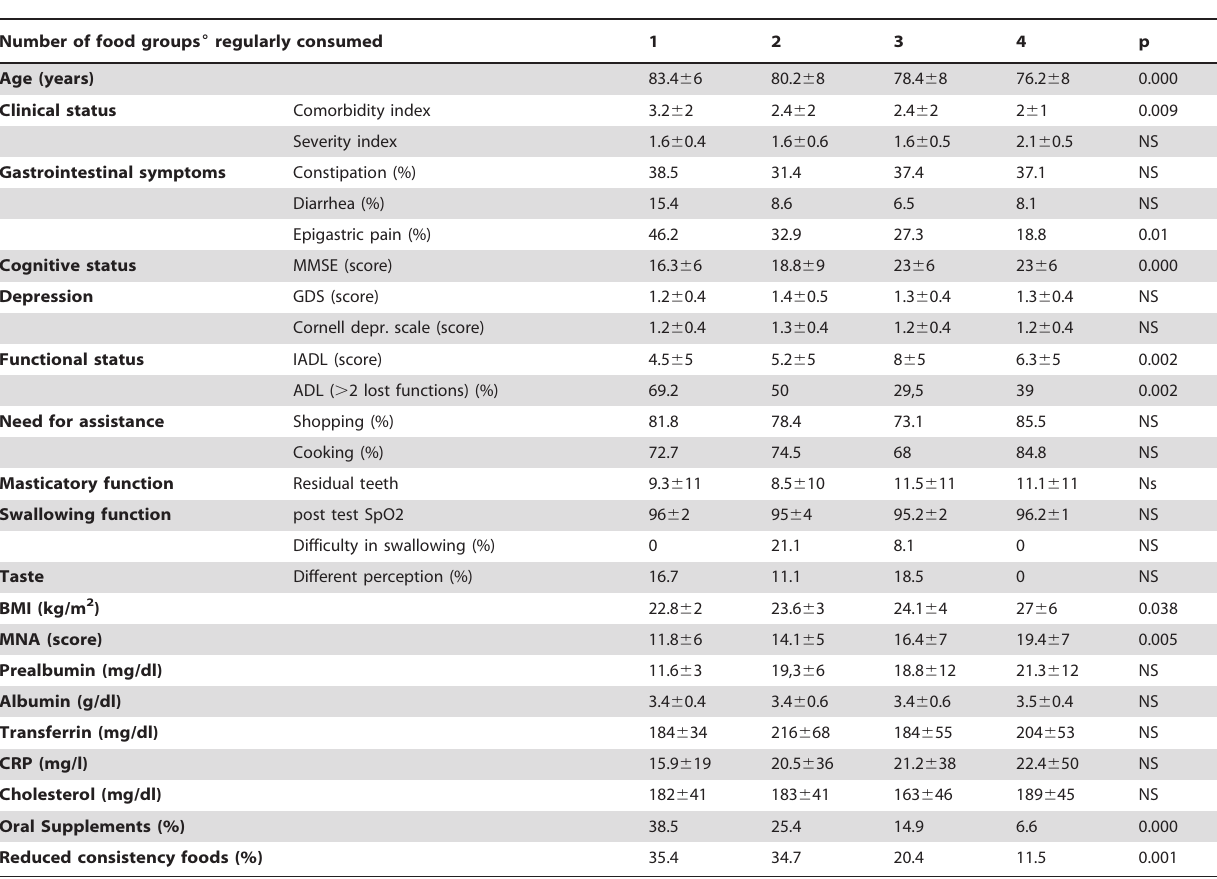
Table 3. Diet Variety and Nutritional Status in Anorexic Subjects 1